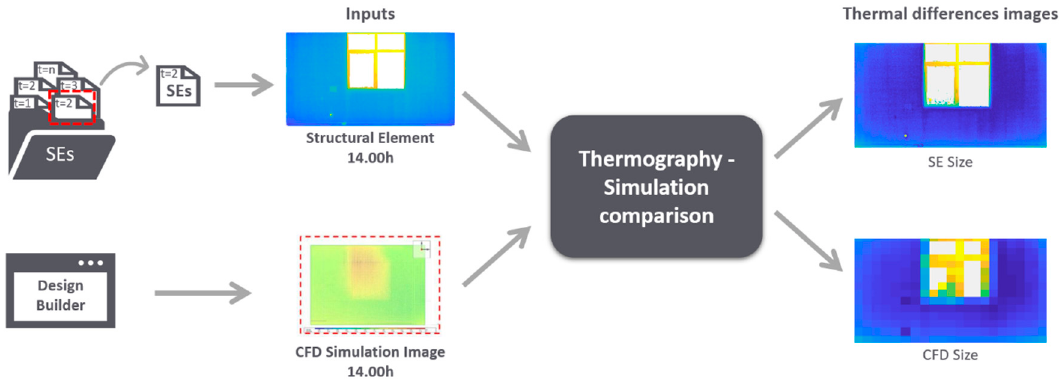
Figure 15. Flowchart of the thermography-simulation comparison process.